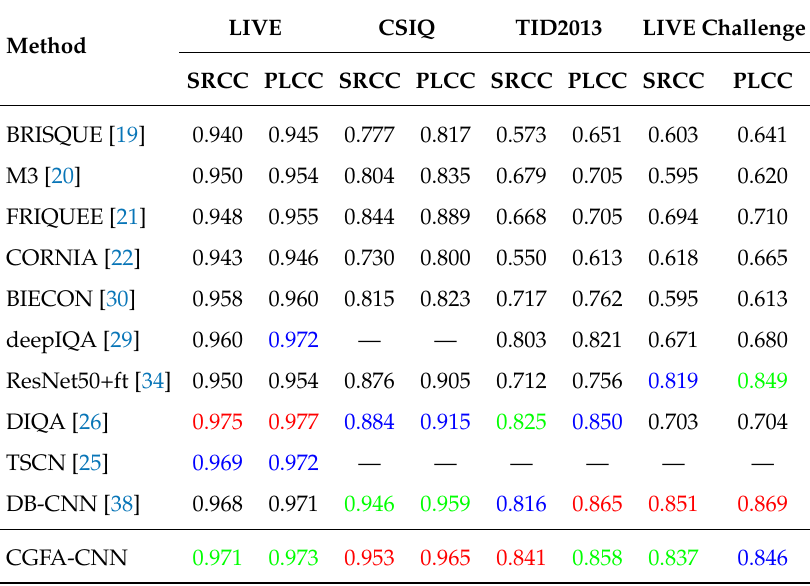
Table 2. Demographic prediction performance comparison by two evaluation metrics. The top three SRCC and PLCC results are highlighted in red, green, and blue,